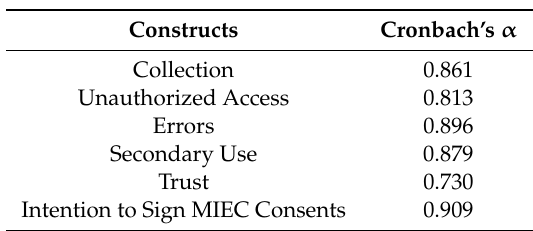
Table 3. Reliability